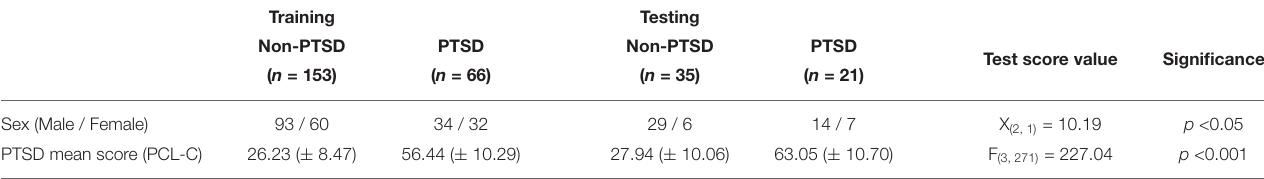
TABLE 2 | Demographics and outcome measures for original partitioning folds.